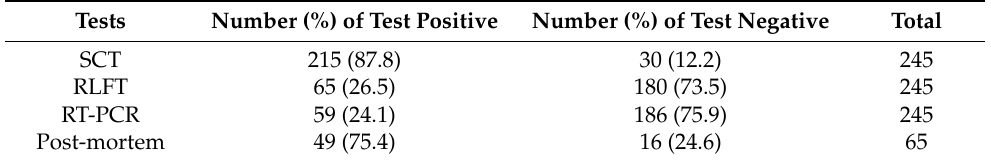
Table 1. Distribution of results for three ante-mortem tests (single cervical tuberculin test (SCT), rapid lateral-flow test (RLFT) and Real-Time PCR (RT-PCR)) and post-mortem test for diagnosis of bovine tuberculosis in dairy cattle ( n = 245) from 11 Egyptian cattle